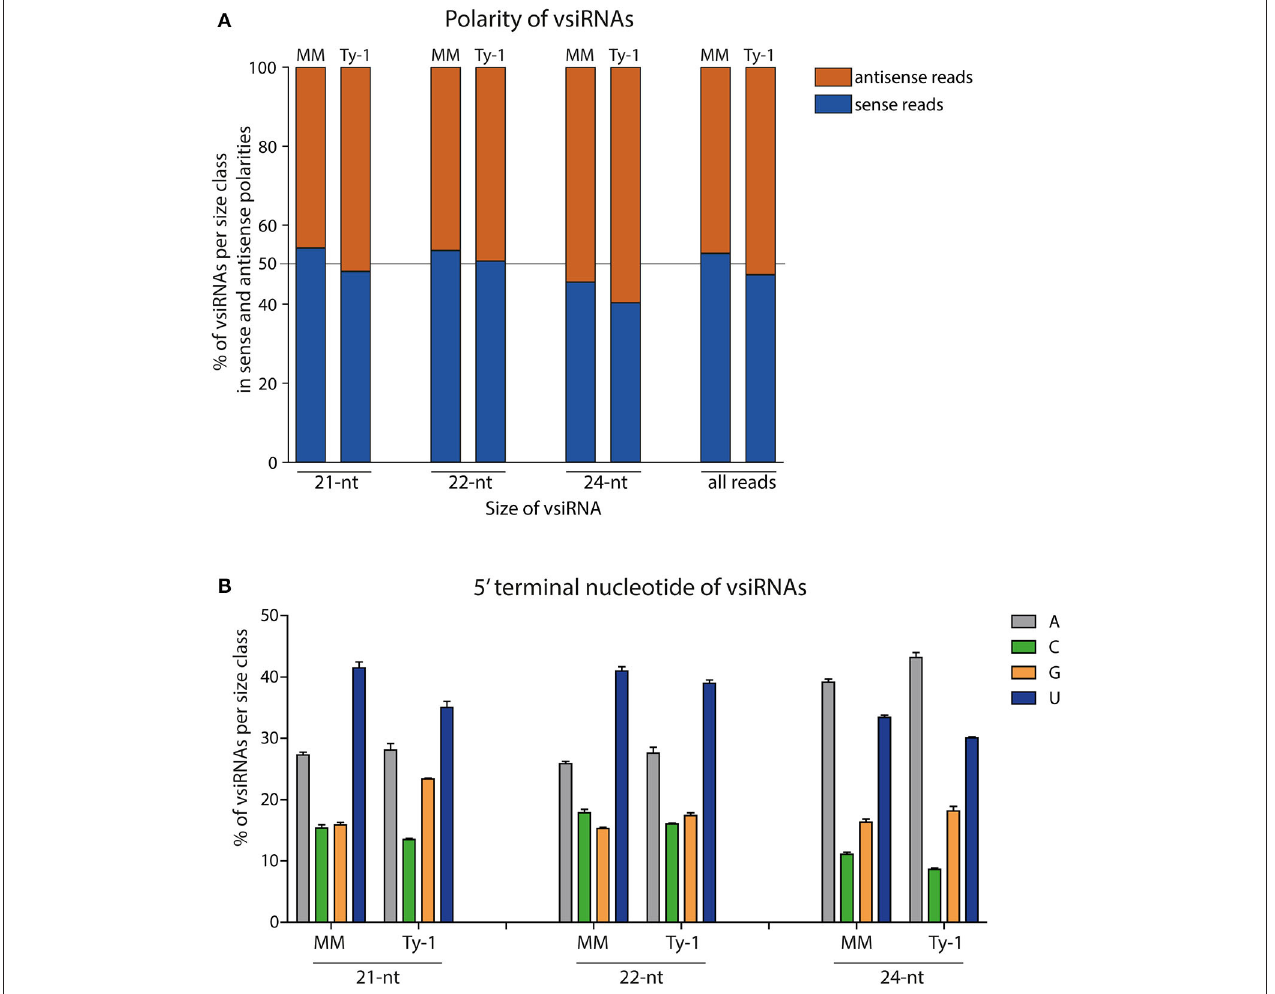
FIGURE 4 | The polarity and 5 ′ terminal nucleotides of vsiRNA reads. (A) Viral siRNAs from TYLCV-infected MM or Ty-1 bearing tomato depicted per size class (21-, 22-, 24-nt or all reads) and showing the percentage of sense and antisense oriented reads. The average of three biological replicates is depicted. (B) siRNAs from TYLCV-infected MM or Ty-1 tomato depicted per size class of 21-, 22-, and 24-nt and showing the percentage of reads containing adenine (A), cytosine (C), guanine (G), or uracil (U) as 5 ′ terminal nucleotide. The bar represents the average and standard deviation of three biological